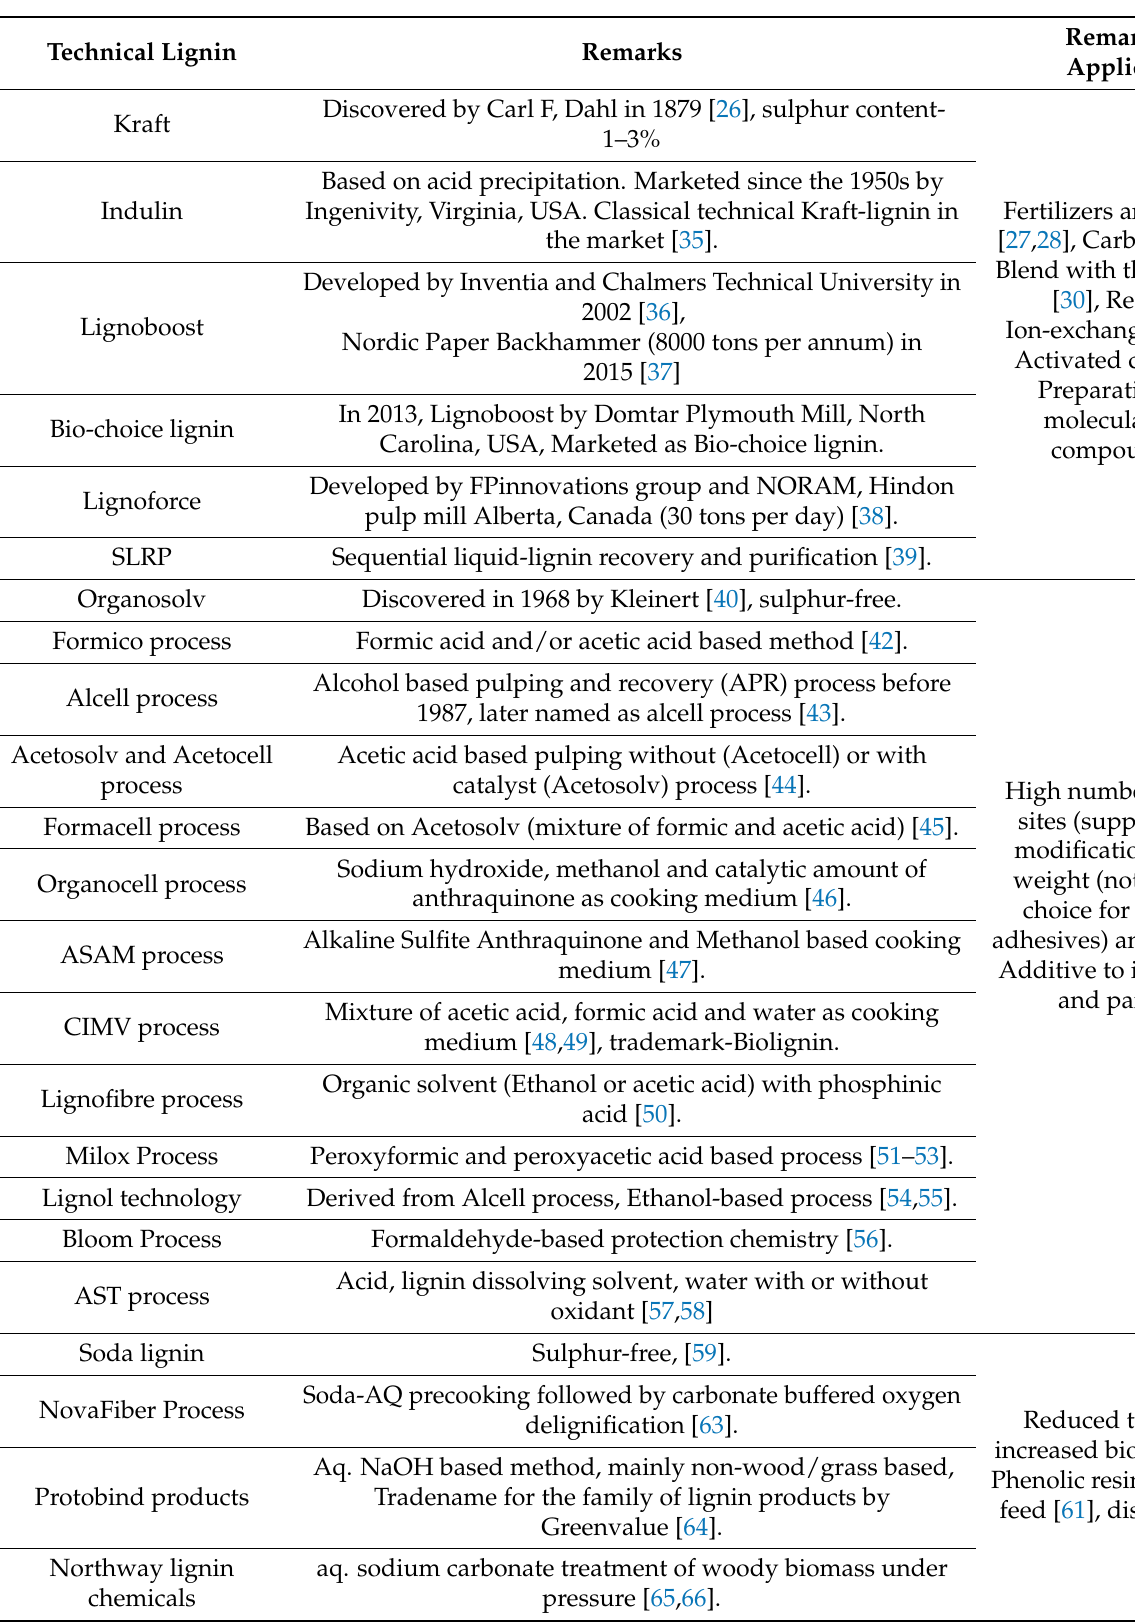
Table 2. Technical lignin and their